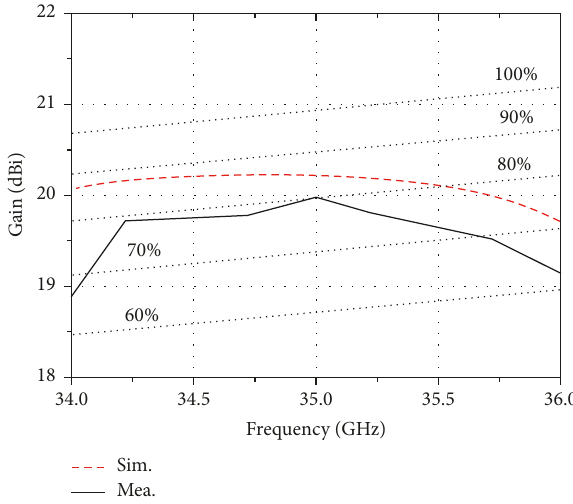
Figure 11: Gain and antenna efficiency of the proposed antenna array at 35